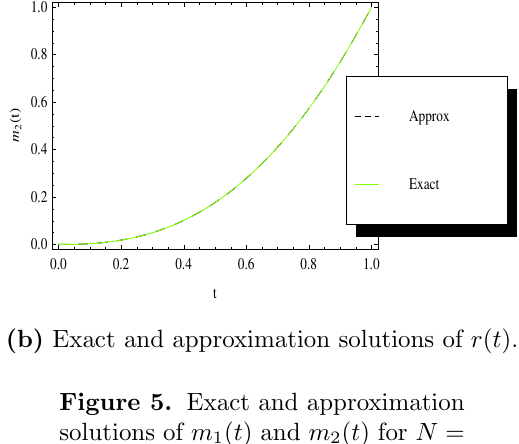
Figure 5. Exact and approximation solutions of m 1 ( t ) and m 2 ( t ) for N =